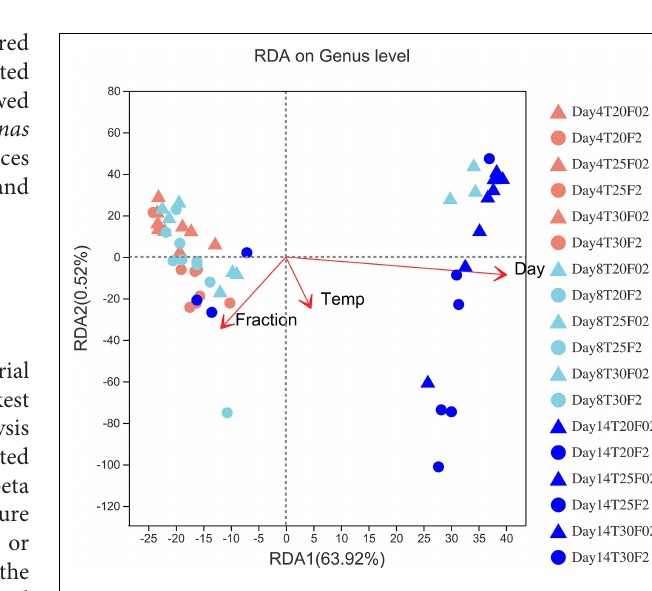
FIGURE 5 | Redundancy analysis (RDA) of microbial communities and environmental variables such as fraction, temperature, and sampling day (red arrows). The lengths of arrows indicate the magnitude of variance to which that variable could be explained. Smaller angles between two variables indicate stronger correlations between